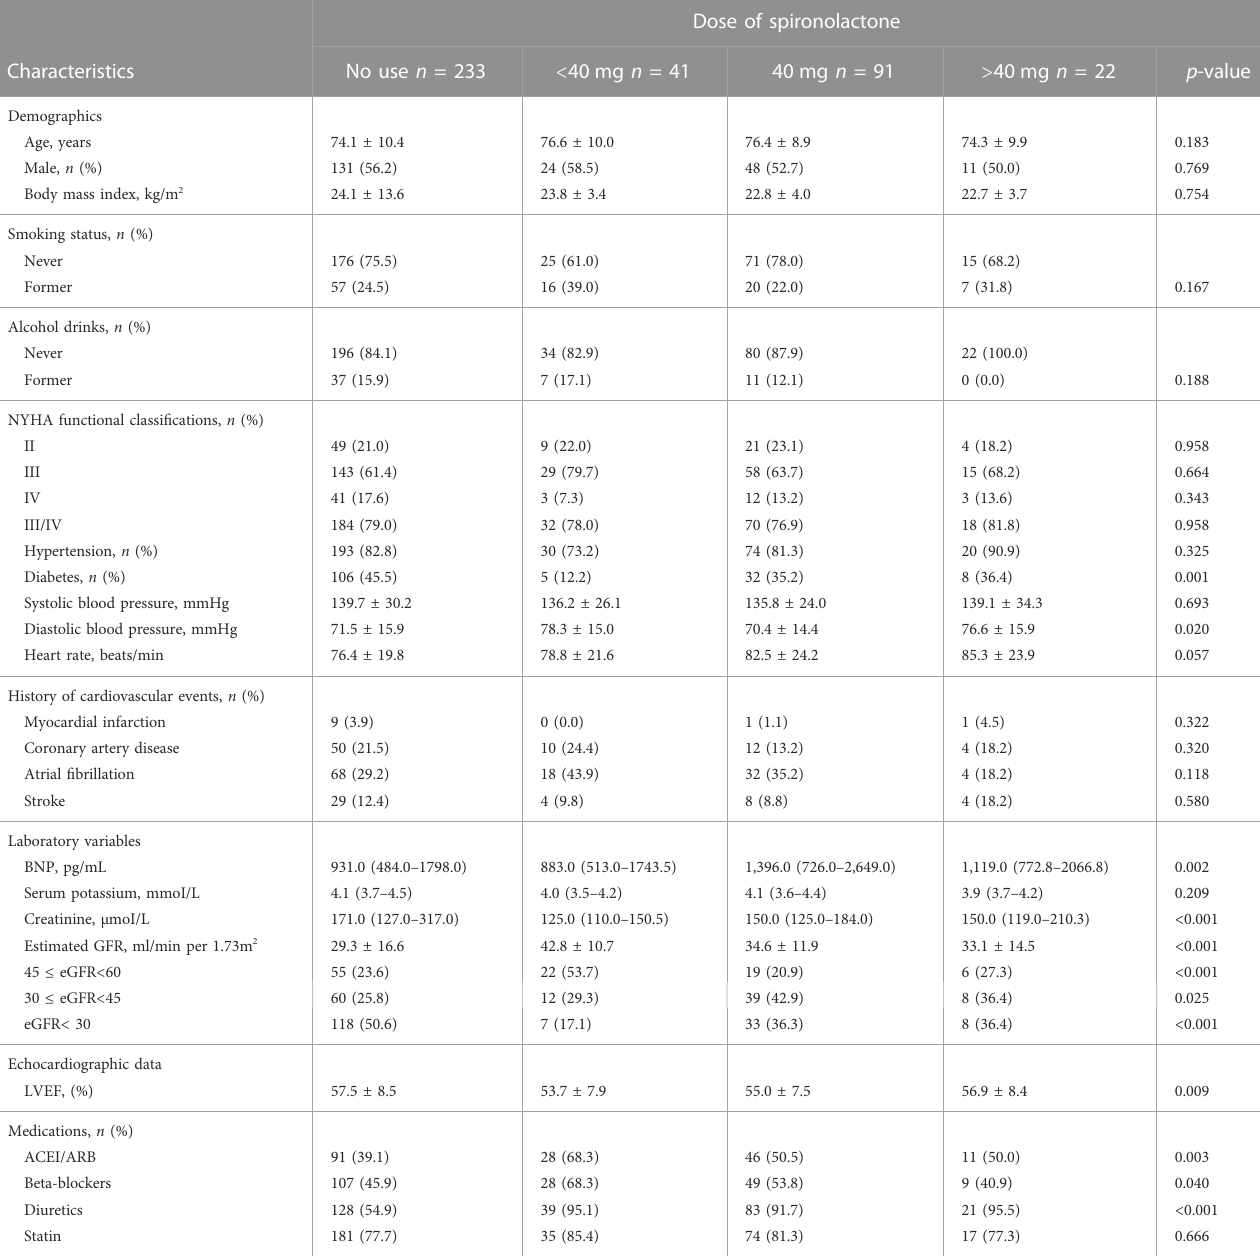
TABLE 2 Baseline characteristics of study patients categorized according to the dose of spironolactone.